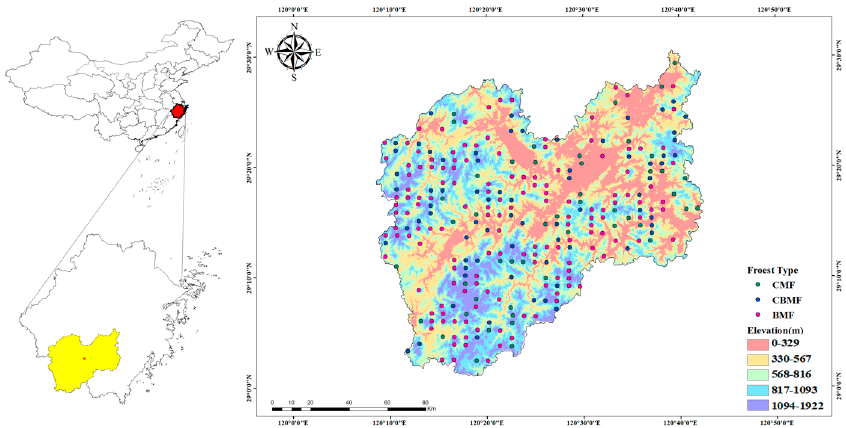
Figure 1. The distribution of sample plots in Lishui, Zhejiang Province, China. Abbreviations refer to forest type: coniferous mixed forest (CMF), coniferous–broadleaf mixed forest (CBMF), and broadleaf mixed forest (BMF).